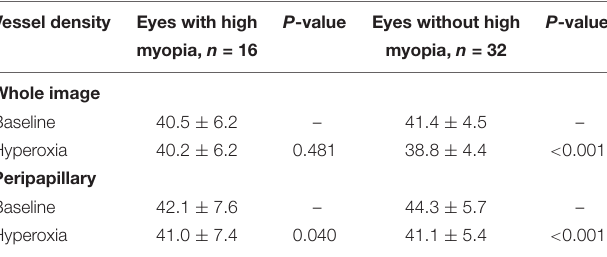
Data are expressed as mean ± standard